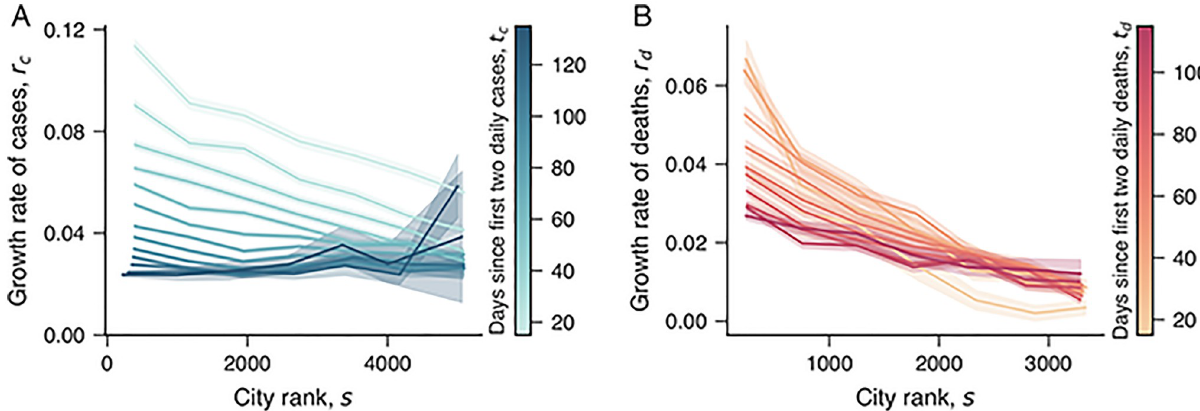
Fig 4. Association between growth rates and city size. (A) Relationship between the growth rate of COVID-19 cases ( r c ) and the city rank ( s ). The different curves show the average values r versus s for different number of days since the first two daily cases ( t , as indicated by the color code). (B) c c Relationship between the growth rate of deaths by COVID-19 ( r d ) and the city rank ( s ). The different curves show the average values r d versus s for different number of days since the first two daily deaths ( t , as indicated by the color d